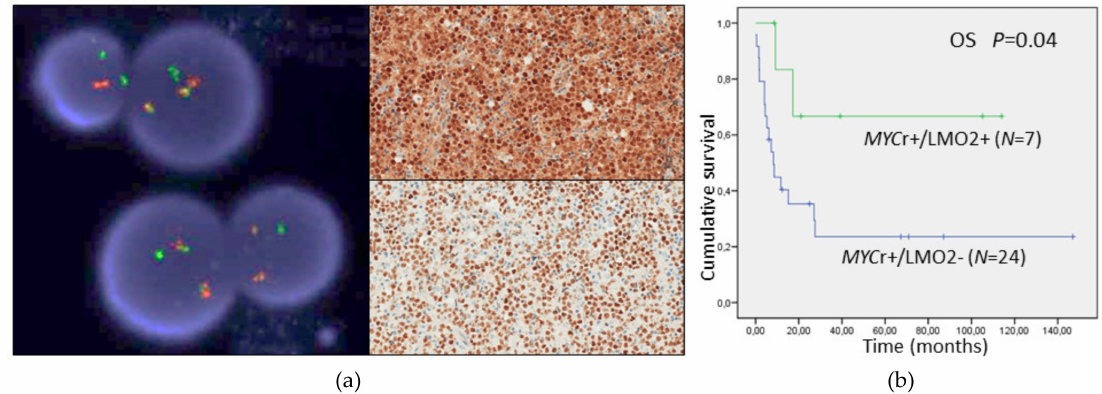
Figure 3. ( a ) An example of dissociated case, with MYC rearranged and high expression of LMO2 protein (up) and MYC protein (down) (case #5 from Figure 2); ( b ) OS comparing MYCr +/ LMO2 + and MYCr +/ LMO2 −